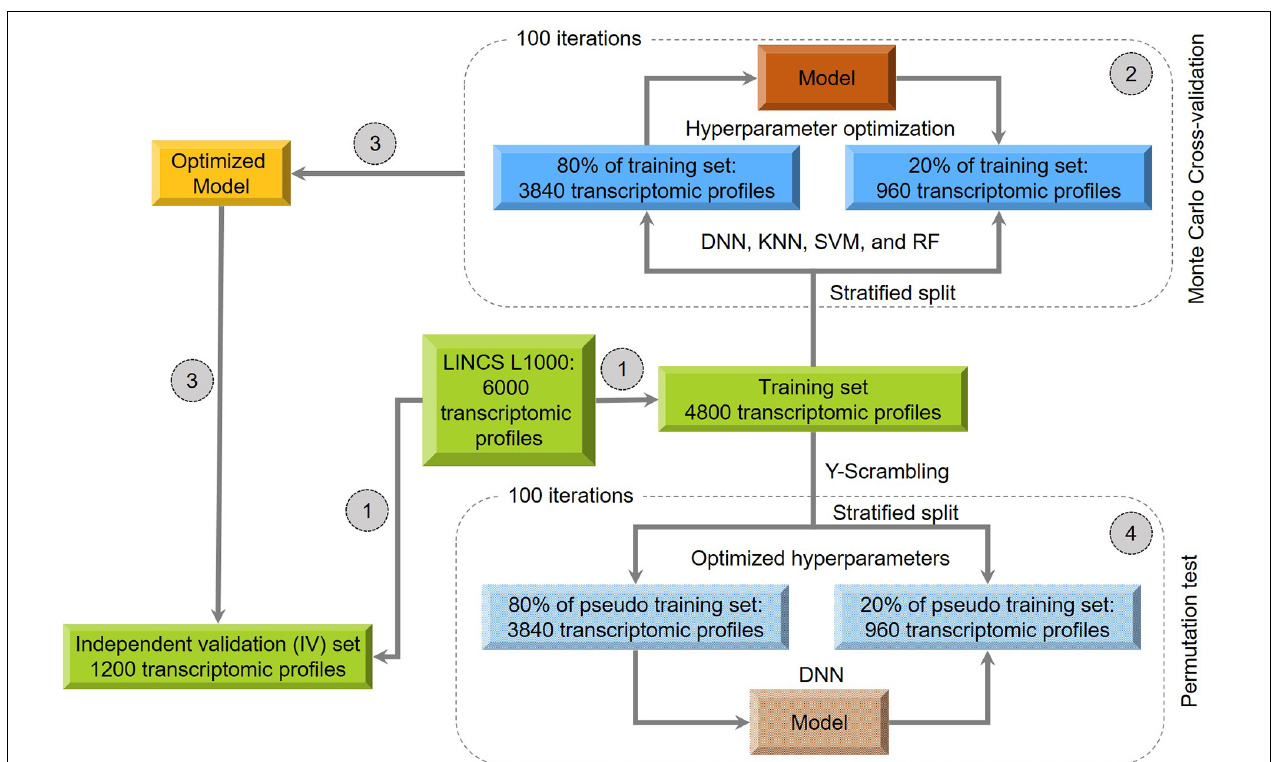
FIGURE 1 | Overall workflow for the model development: (1) 6000 treatments were stratified split into the training (80%) and independent validation (20%) datasets. (2) A 100-iteration Monte Carlo cross-validation (MCCV) was carried out for hyperparameter optimization of the four algorithms, including Deep Neural Network: DNN; K-nearest neighbors: KNN); Support Vector Machine: SVM and Random Forest: (RF). (3) The optimized models were used to predict the independent validation sets. (4) the DNN model was further evaluated by using a “Y-Scrambling”-based permutation